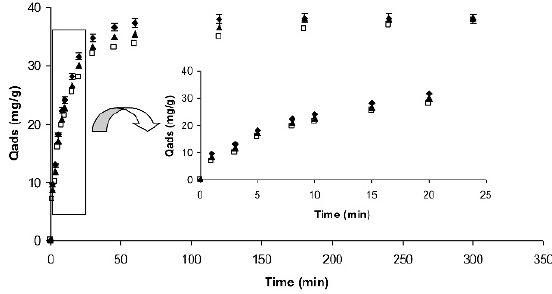
Figure 3. Effect of particles size on phenol adsorption over HBEA ze- olite of 0.05–0.07 mm ( (cid:7) ),0.2–0.4 mm ( (cid:78) ) and 0.6–0.7 mm ( (cid:3) ).